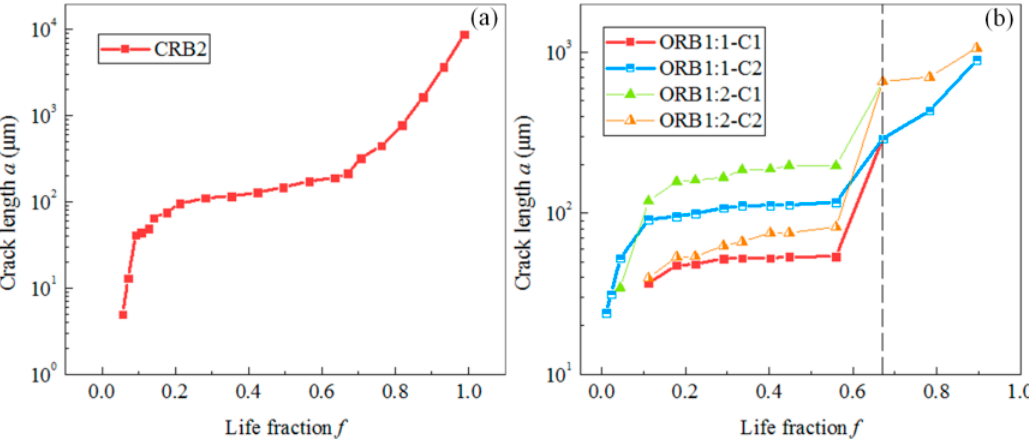
Figure 11. Curves showing crack length as a function of life fraction: ( a ) CRB2; ( b ) ORB1.